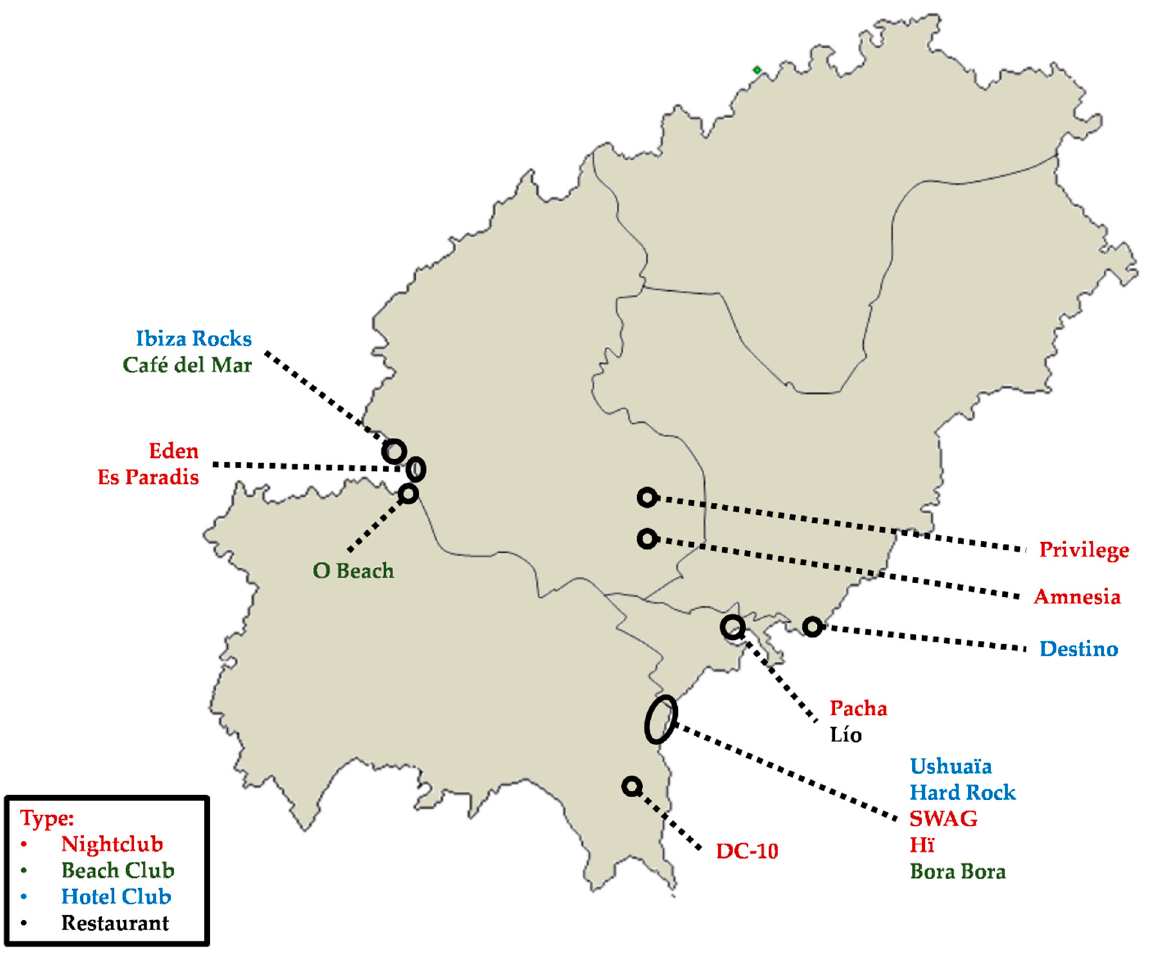
Figure 2. Main nightlife venues in 2021 (own elaboration).